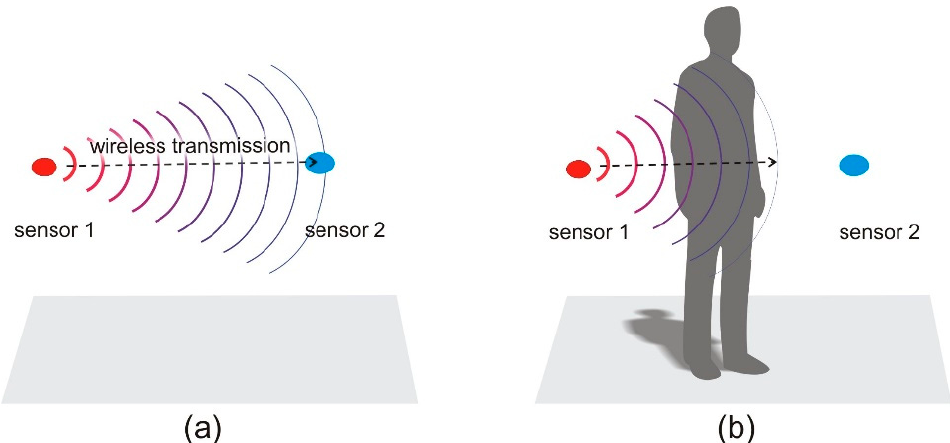
Figure 1. Influence of body shadowing on wireless transmission between sensors: ( a ) No shadowing, successful transmission; ( b ) body shadowing that affects transmission